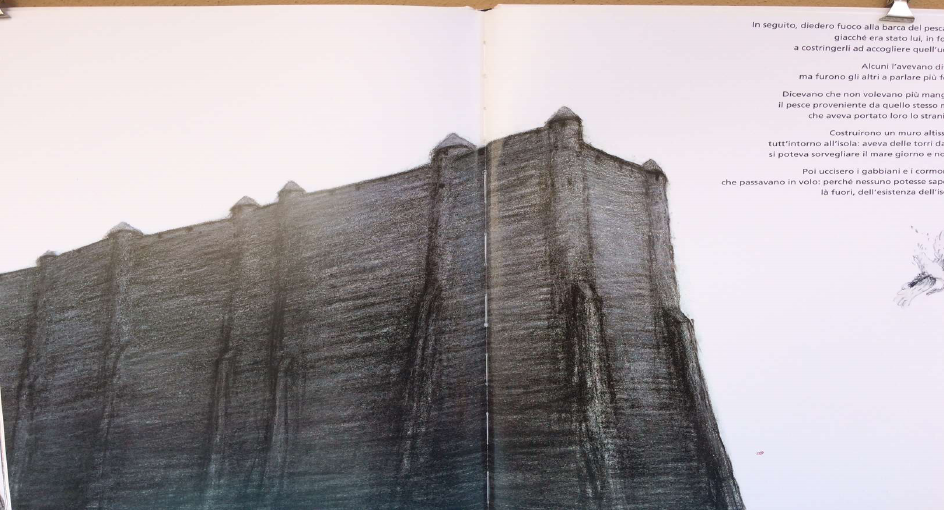
Figure 8. The construction of the wall, from: L’isola , cit. pp.